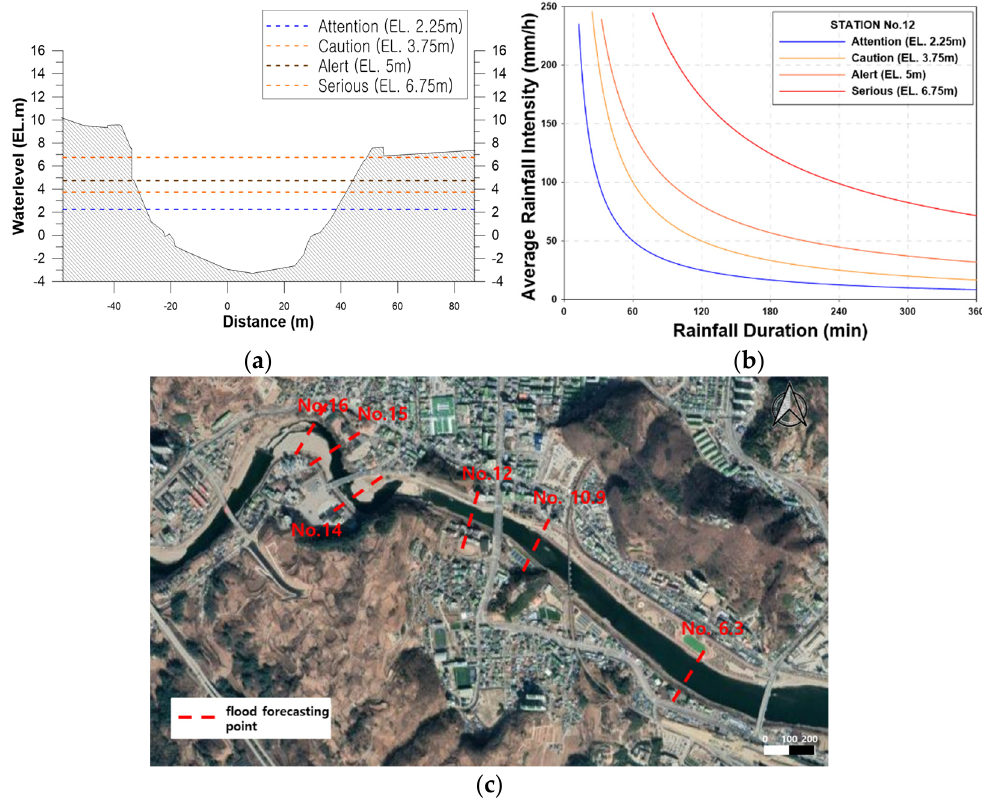
Figure 7. The criteria of flood risk and flow nomograph. ( a ) Cross-section and criteria of flood risk; ( b ) Flow nomograph at station 12; ( c ) Stations of flow nomograph development. ( b ) Flow nomograph at station 12; ( c ) Stations of flow nomograph